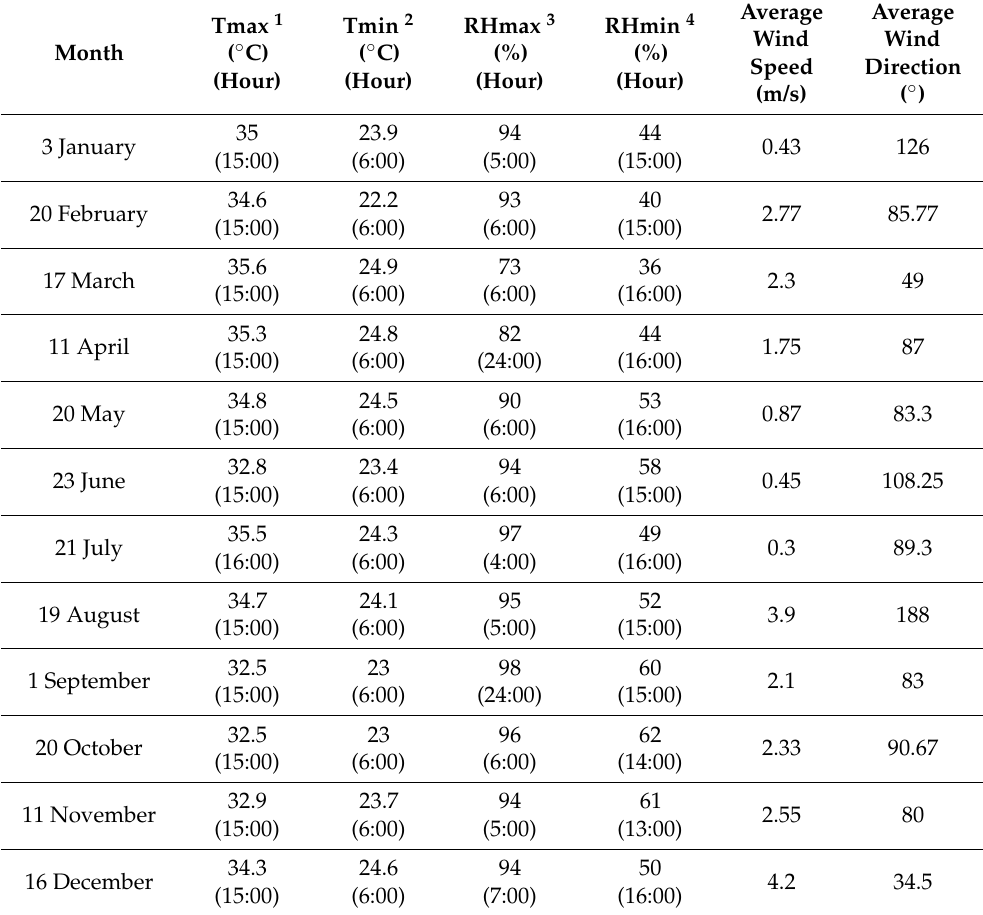
Figure 3. Comparison between maximum and minimum temperatures and relative humidity for each month of the year.